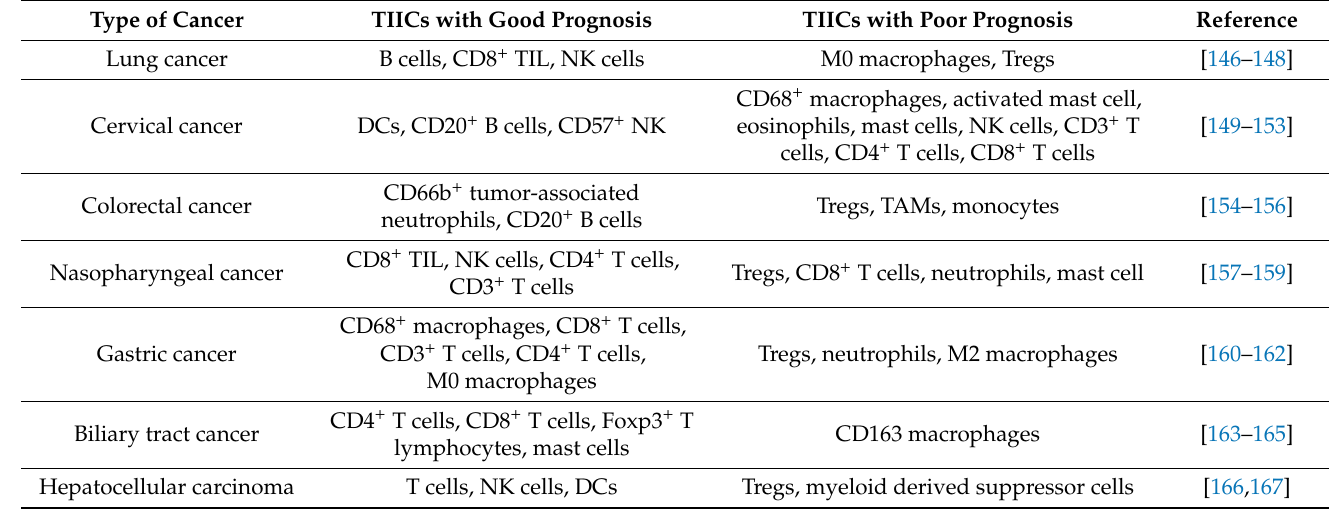
Table 1. The relationship between different TIICs and tumor